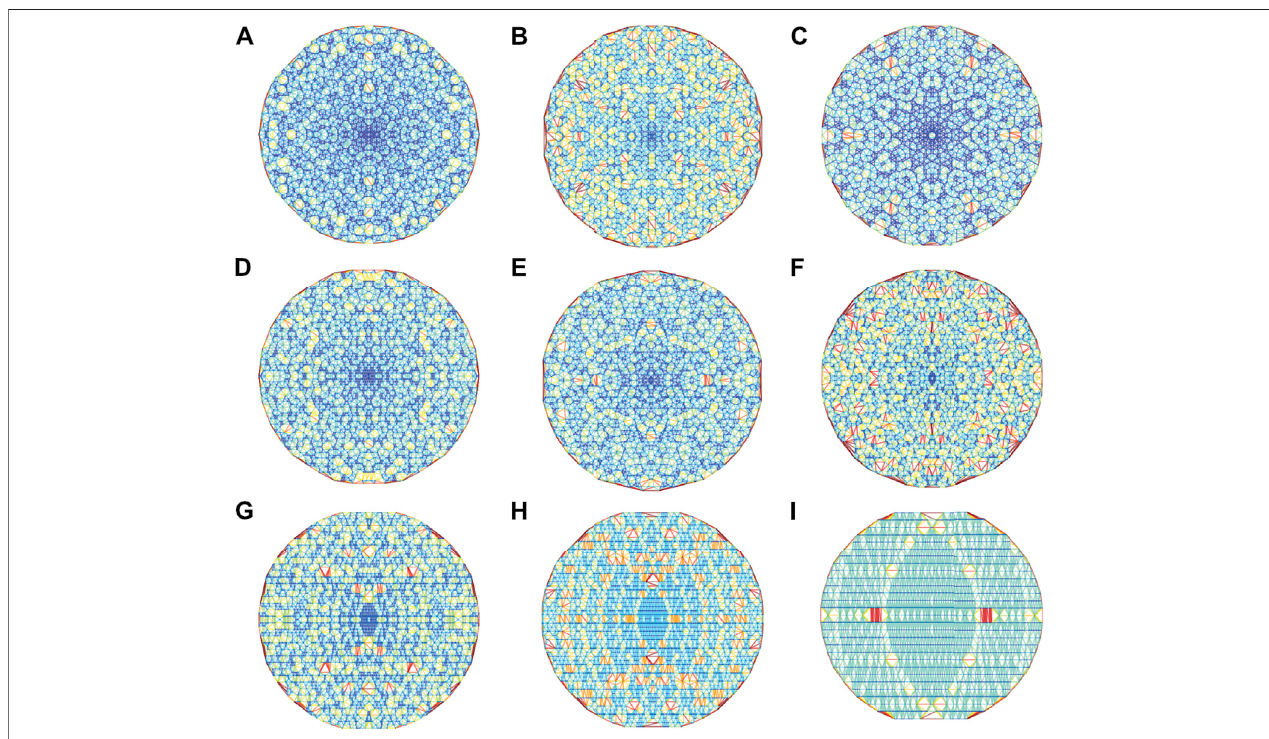
FIGURE 3 | (A – I) Delaunay triangulation with color-coded edge according to their lengths of the point patterns displayed in Figure 1 . The edge lengths increase from blue (i.e., the shortest edge of the Delaunay triangulation of each CPA) to red (i.e., the longest edge of the Delaunay triangulation of each CPA).